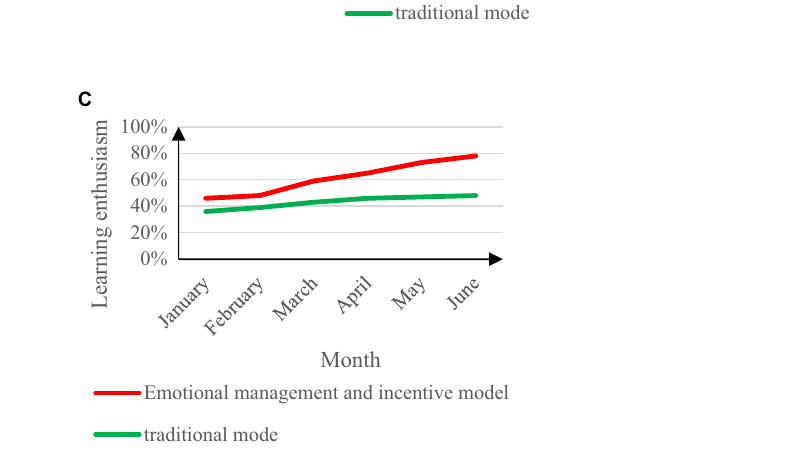
FIGURE 7 Comparison of students’ enthusiasm for learning. (A) The enthusiasm of the first-year students to study. (B) The enthusiasm of the second-year students to study. (C) Enthusiasm for junior students to study.